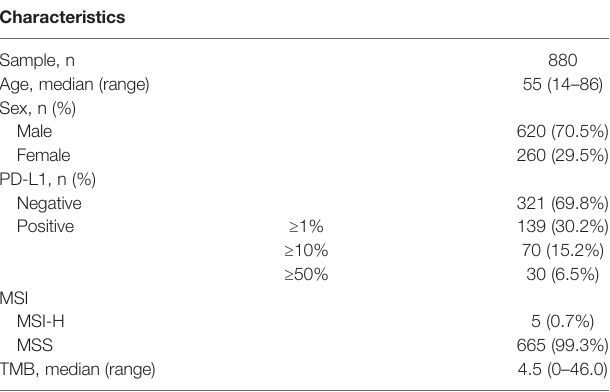
TABLE 1 | Clinicopathologic